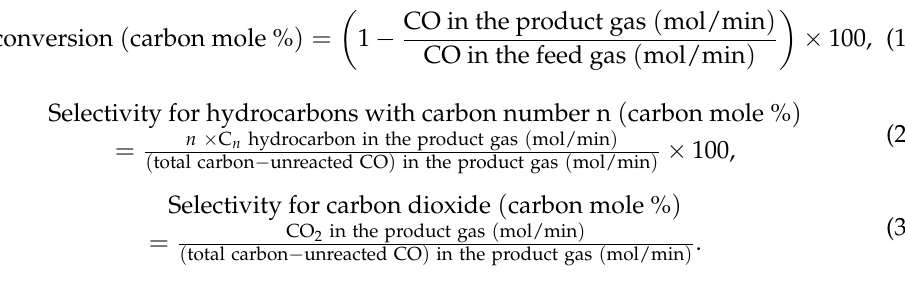
Figure S3: CO conversion and hydrocarbon selectivity of the 40CFAl catalyst prepared at pilot scale as a function of time on steam; Figure S4: Time on stream of selectivity over the 40CFAl_P catalyst under two different conditions ((a) 6000 mL/g/h, 300 ◦ C; and 10 bar; (b) 4000 mL/g/h, 350 ◦ C, and 20